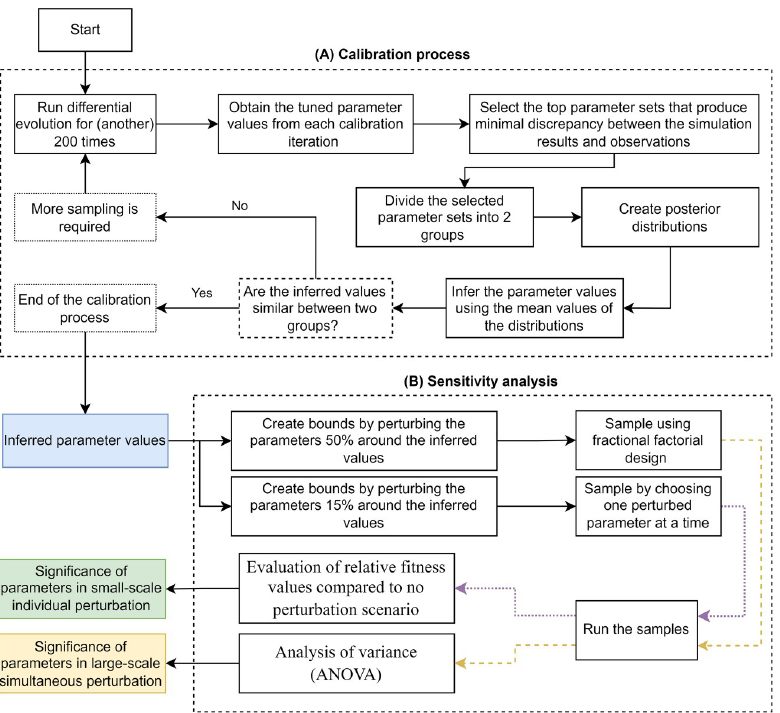
Fig 11. The complete flow of the calibration process and the sensitivity analysis implemenetd in this study. S1 Fig. Dispersity of the parameter values obtained during the calibration process for differ- ent calibration scenarios of C1, C2, C3, C4, C5 and C1-5. Individual runs are the results of each calibration process; All samples represent the mean of combined individual runs; First (1st) and second (2nd) halfs of samples indicate the means of the frist half and second half of com- bined individual runs, respectively. The values were scaled by dividing by the length of the priors. (TIFF) S1 Table. The summary of the specifications of the cell culture experiments used to esti- mate the model’s free parameters. S2 Table. The fuzzy logic rules in IF/THEN format. The words in green are the cellular inputs while those in red are cellular outputs. S3 Table. The list of the free parameters in the present model, and the inferred values dur- ing different calibration schemes. Those marked by ‘-‘were not inferred during that particu- lar calibrations scenario.